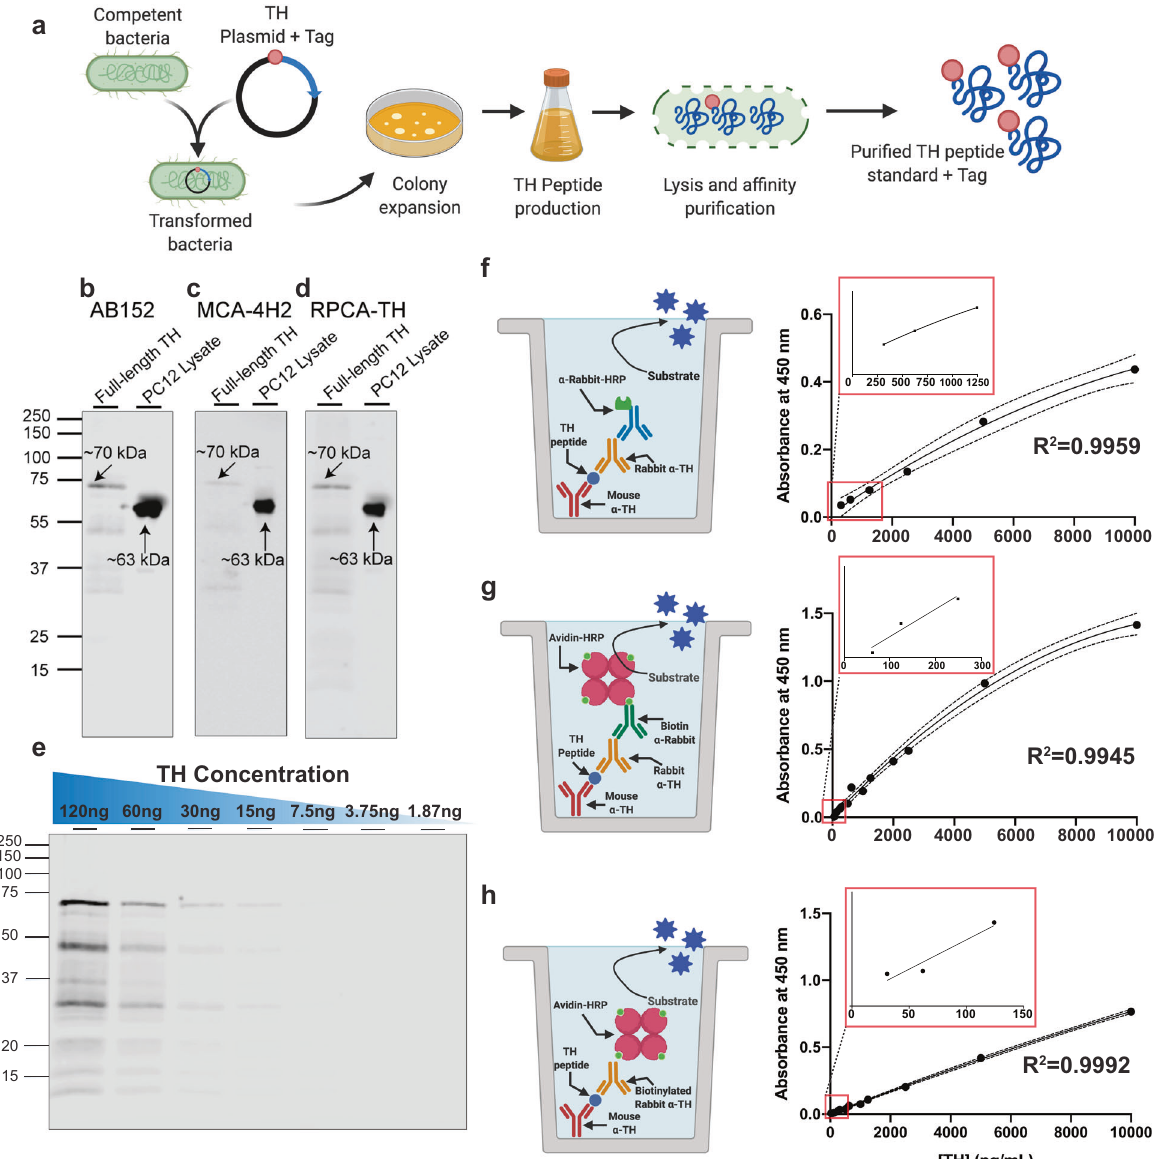
Fig. 1 Establishing a reproducible quantitative Bio-ELISA to detect tyrosine hydroxylase. a – d TH is detectable in recombinant form and in PC12 crude lysate using af fi nity-puri fi ed rabbit polyclonal TH antibody AB152 (Sigma), and antibodies selected for this ELISA, mouse monoclonal MCA-4H2 (EnCor), and rabbit polyclonal RPCA-TH (EnCor). e Using AB152, we probed the lower threshold for TH detection via serial dilution of puri fi ed recombinant TH from 6 to 0.094 μ g/mL followed by Western blot and near-Infrared detection, considered to be a sensitive method for protein detection on Western blot. We demonstrate IR detection is reliable to a lower threshold of ~15 ng TH. Below this limit, TH detection becomes unreliable with IR detection. f – h In a series of stepwise experiments designed to increase ELISA sensitivity and decrease background, we achieved lower detection limits of 15 pg/mL TH ( h ). Capture antibody and detection antibody in all three methods were MCA-4H2 (1:1000 dilution from 1 mg/mL) and RPCA-TH (1:6000 dilution from 1 mg/mL). Schematic representation of each method shown on the left with a representative standard curve on the right. f Incubation with detection antibody followed by an HRP-conjugate secondary yielded a lower detection threshold of 125 pg/mL. g Addition of a tertiary layer using anti-rabbit biotin followed by Avidin-HRP improved lower detection threshold to 62.5 pg/mL but resulted in increased background. h Use of the biotinylated detection antibody (RPCA- TH-biotin, 1:6000 dilution from 1.65 mg/mL) followed by avidin-HRP yielded the lowest detection threshold of 15 pg/mL, with maximum sensitivity and minimal background. f – h Insets (red outline) shows a magni fi ed lower standard curve to illustrate TH expression is shown as unit TH (picogram or nanogram) per mg human macrophages (~300pg TH/mg total protein) (Fig. 3a), total protein, as determined by the Lowry assay. PC12 homogenate suggesting the Bio-ELISA is applicable to cell and tissue samples provided a reliable positive control expressing high levels of TH (>10ng derived from human and murine specimens, paving the way for its TH/mg total protein), while HEK293 homogenate showed no application in translational and preclinical studies involving measure- detectable levels of TH, in at least six independent replicates. As ments of TH protein. We should note that, unlike cultured human anticipated, cultured dopamine neurons from postnatal mice showed monocyte-derived macrophages, cultured dopamine neurons contain greater TH concentrations (~700pg TH/mg total protein) than cultured various cell types, and consist of 12 – 16% dopamine neurons.